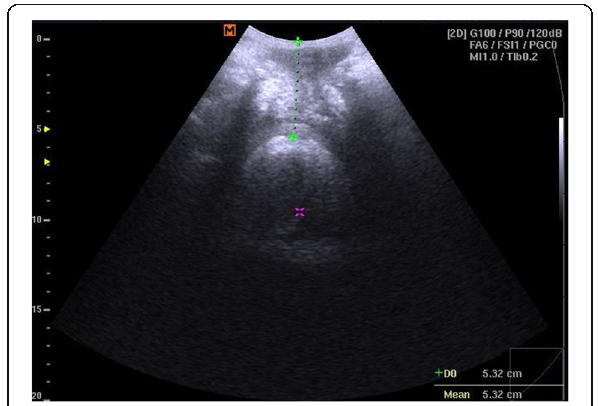
Fig. 5 Fetal head perineum distance (3). HPD is 5.32 cm rounded down to 5 cm measured by TPUS